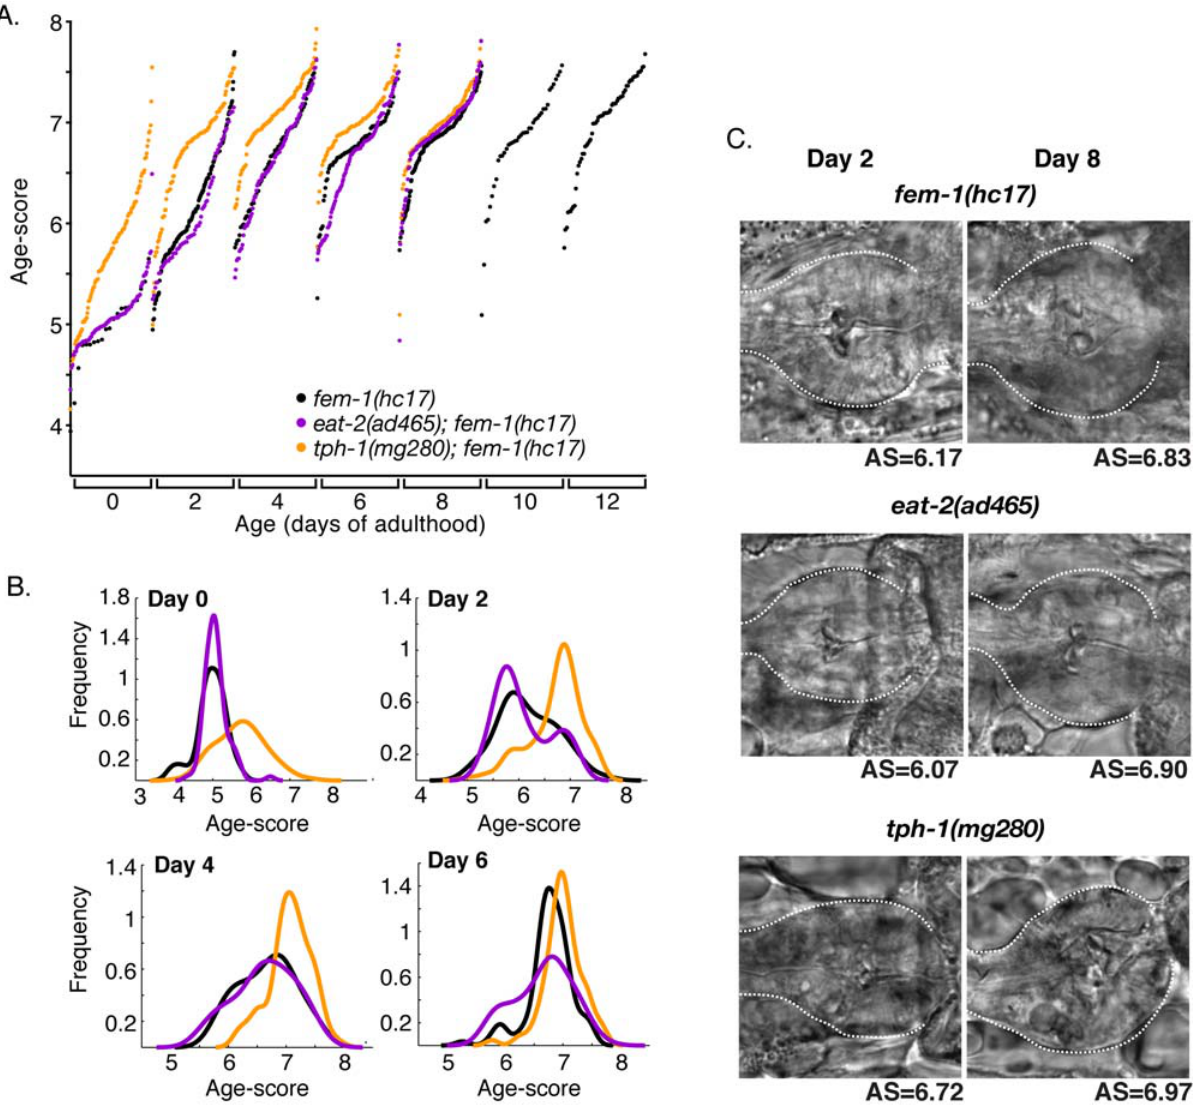
Figure 5. Image analysis revealed altered morphology states in slow-pumping eat-2(ad465) animals and serotonin-deficient tph- 1(mg280) animals. (A) Age-scores assigned by a model trained on fem-1(hc17) days 0 to 12 for test images from normal and mutant animals were formatted the same way as Fig 3(B). The number of test images for each age class ranged between 68 and 117. (B) Probability distributions of fem- 1(hc17) , tph-1(mg280) , and eat-2(ad465) age scores from days 0, 2, 4 and 6 from (A). A slight rightward shift is noted in day 6 eat-2(ad465) images. The images of tph-1(mg280) adults attained higher-than-normal age scores at all ages except day 6, possibly reflecting aberrant morphology. (C) Representative images of each strain at ages 2 and 8 were selected as having age scores (AS) near the population means. Lower left image of tph- 1(mg280 ) day 2 pharynx reveals aberrant morphology. Lower right image of day 8 tph-1(mg280) shows structural deformation similar to that seen in day 8 fem-1(h17) and eat-2(ad465)